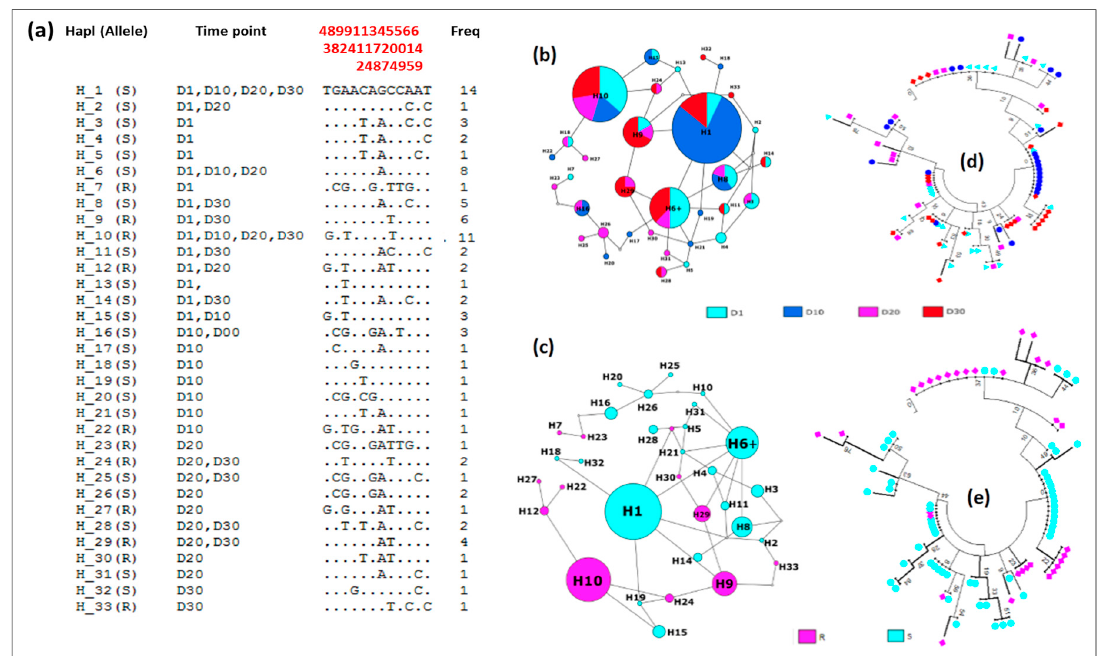
Figure 4. Genetic diversity parameters of GSTe2 in An. funestus s.s. from Mibellon (Cameroon) in relation to the longevity of adult mosquitoes. ( a – c ) haplotype diversity in relation to the alleles at different time points; ( d , e ) phylogenetic trees (using a maximum likelihood method) between mosquitoes at the different time point after the emergence of F1 adult with respect to the